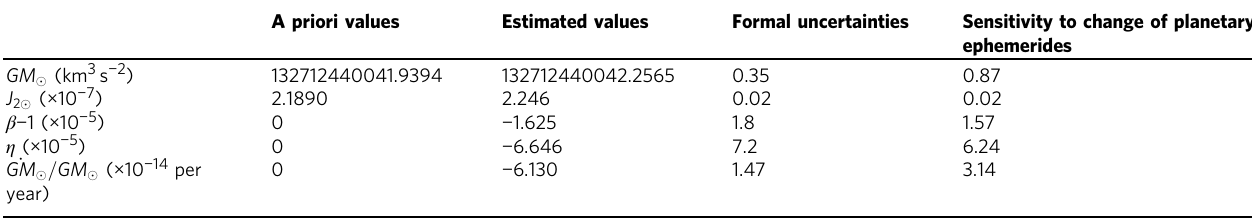
The formal uncertainties are given by the covariance matrix of the least-square solution, which does not include possible mismodeling of GMs and states of the other planets, and asteroids of the solar system. The third column reports the maximum discrepancies between solutions that we obtained by using the JPL DE430, DE432, or DE436 ephemerides to model the third-body perturbation of the planets. The ephemerides of the asteroids are based on the JPL AST343DE430 17 for the three